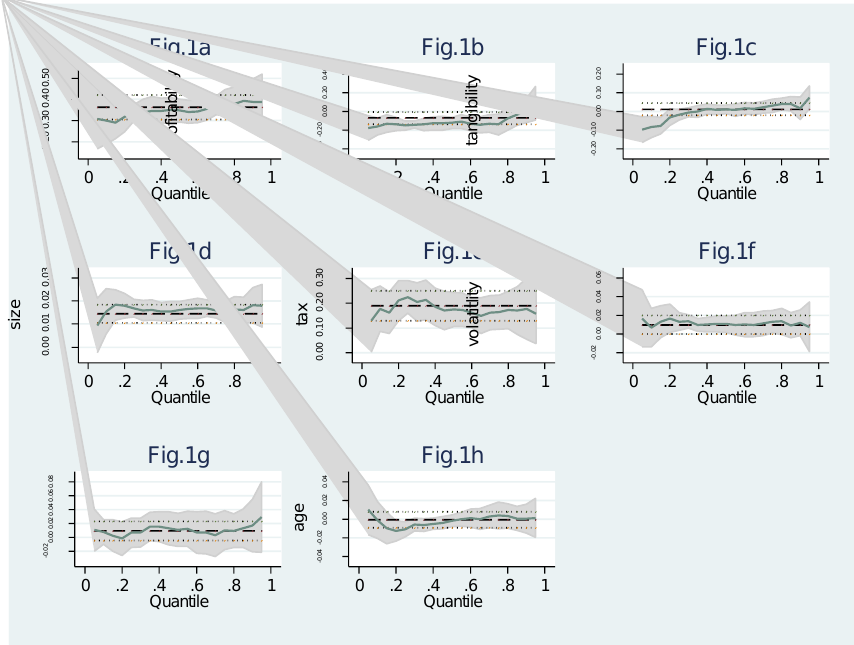
FIGURE 1: Plots of coefficients over quantiles for total-debt ratio (TDR)